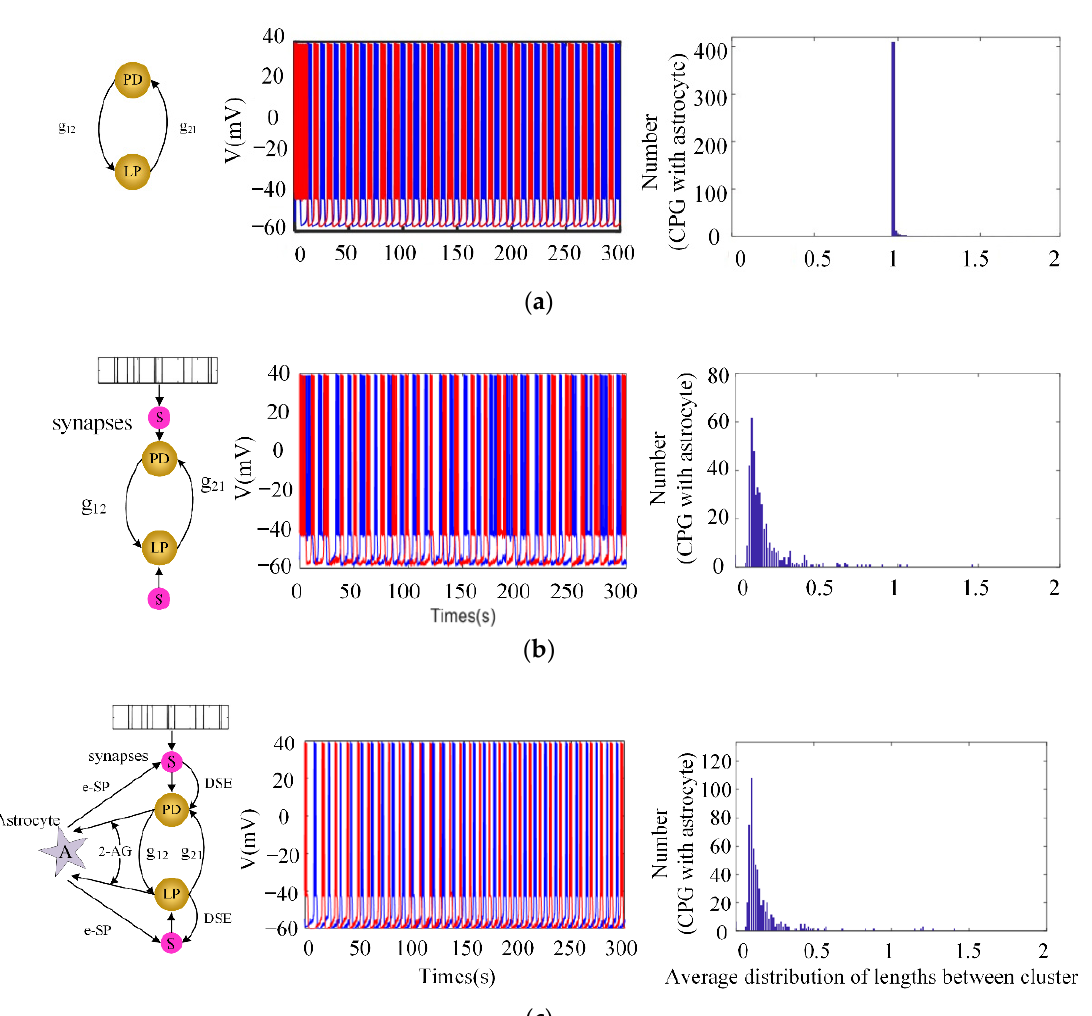
Figure 3. The time series of membrane potentials and frequency histograms of inter-cluster length of ( a ) the ideal minimum CPG neuron network without external stimulation, ( b ) the minimal CPG network in the absence of astrocytes and with external random stimulation, and ( c ) the BiSRP-CPG network with external random stimulation.